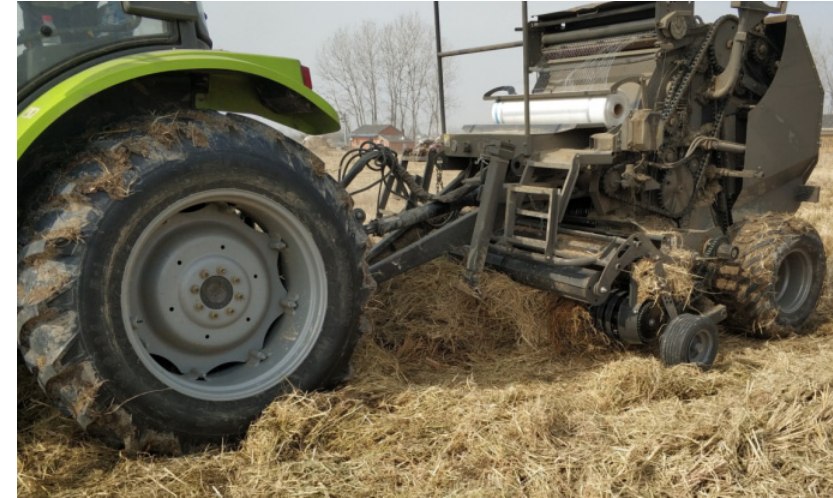
Figure 5. Field tests.